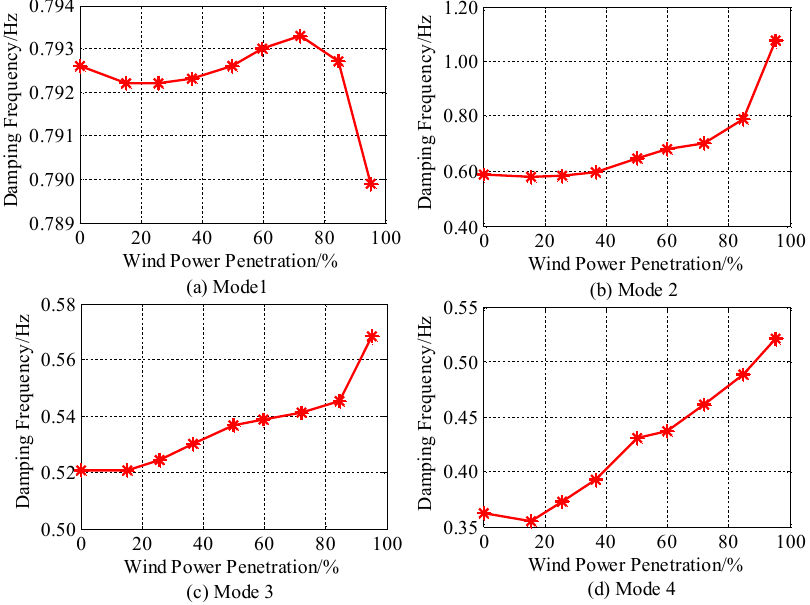
Figure 4. Frequencies of interarea modes vs. wind power penetration. ( a ) Mode 1; ( b ) Mode 2; ( c ) Mode 3; ( d ) Mode 4.